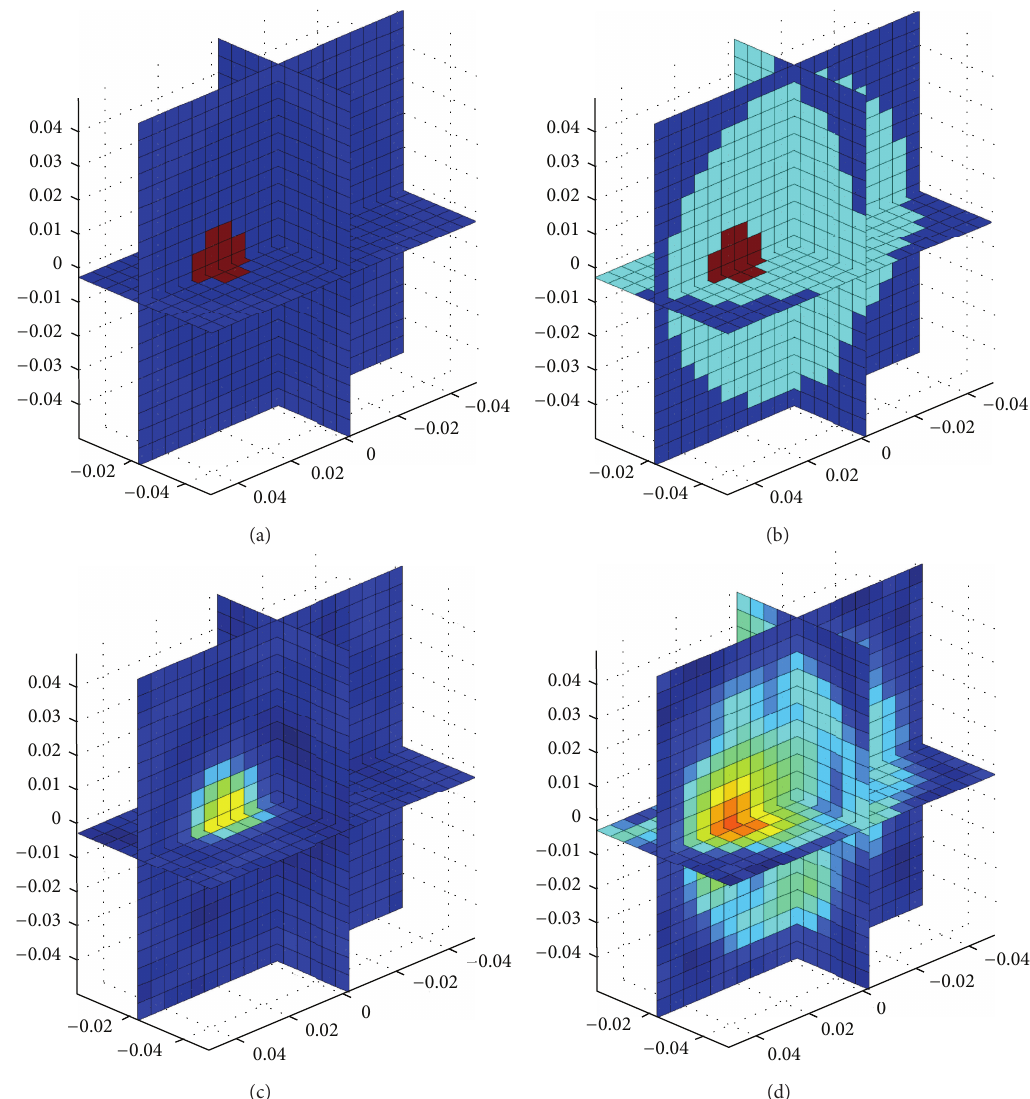
Figure 11: Exact permittivity (top) and reconstructed permittivity (bottom) for the numerical simple breast phantom with a 2 cm diameter tumor and without skin. Real part (left) and − imaginary part (right). The SNR of the data is 30 dB. Distances are in m.